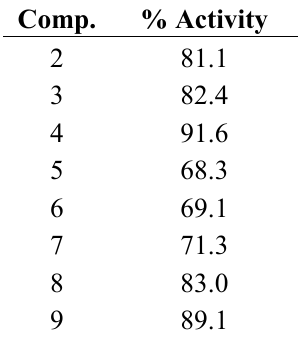
Table 3. Antioxidant activity of the isolated